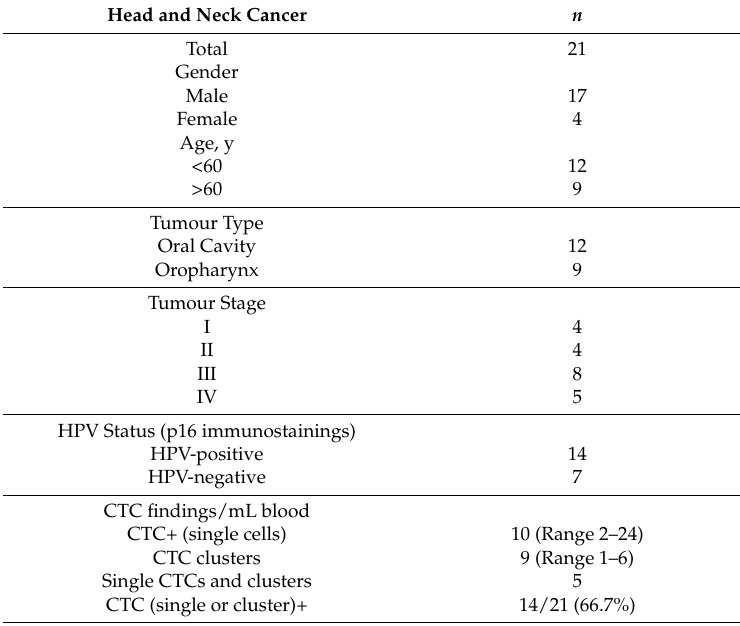
Table 1. Clinicopathological findings for the head and neck cancer cohort ( n = 21) and CTC findings (single/clusters). HPV: Human papillomavirus